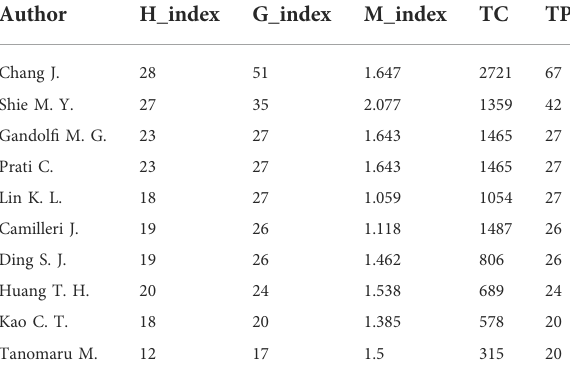
TABLE2Publicationofthetop10authorsinCSBaboutmedicine fi eld.